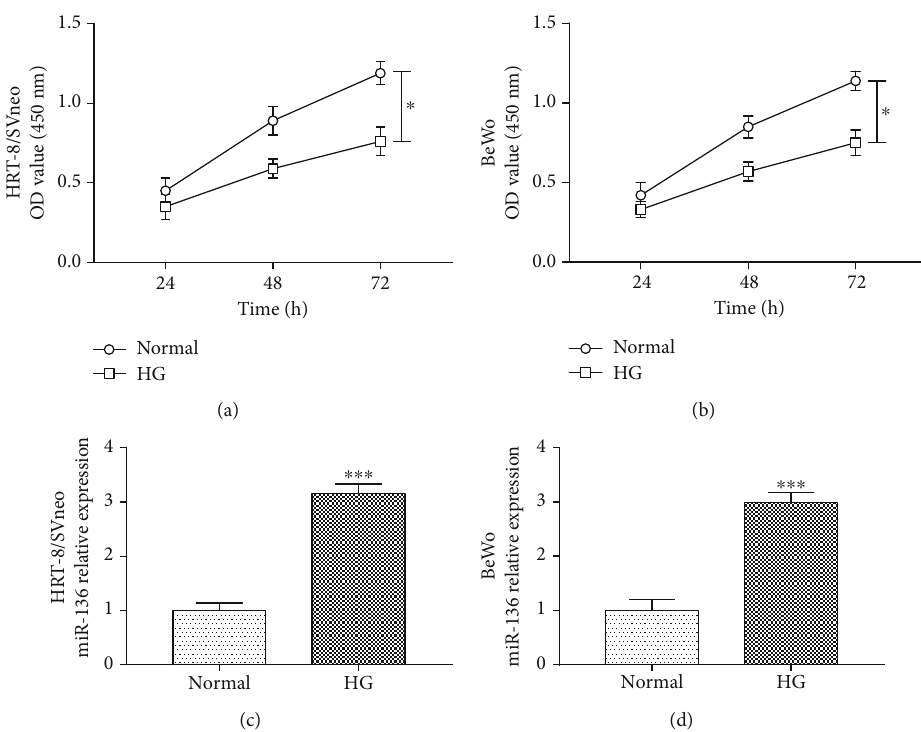
Figure 2: High-glucose treatment regulates trophoblast cell proliferation and miR-136 expression in HRT-8/SVneo and BeWo cells. (a, b) High glucose led to inhibited trophoblast cell proliferation ( ∗ P < 0 : 05 ). (c, d) miR-136 expression was increased in both HRT-8/SVneo and BeWo cells under high-glucose conditions ( ∗∗∗ P < 0 : 001 ). HG: high